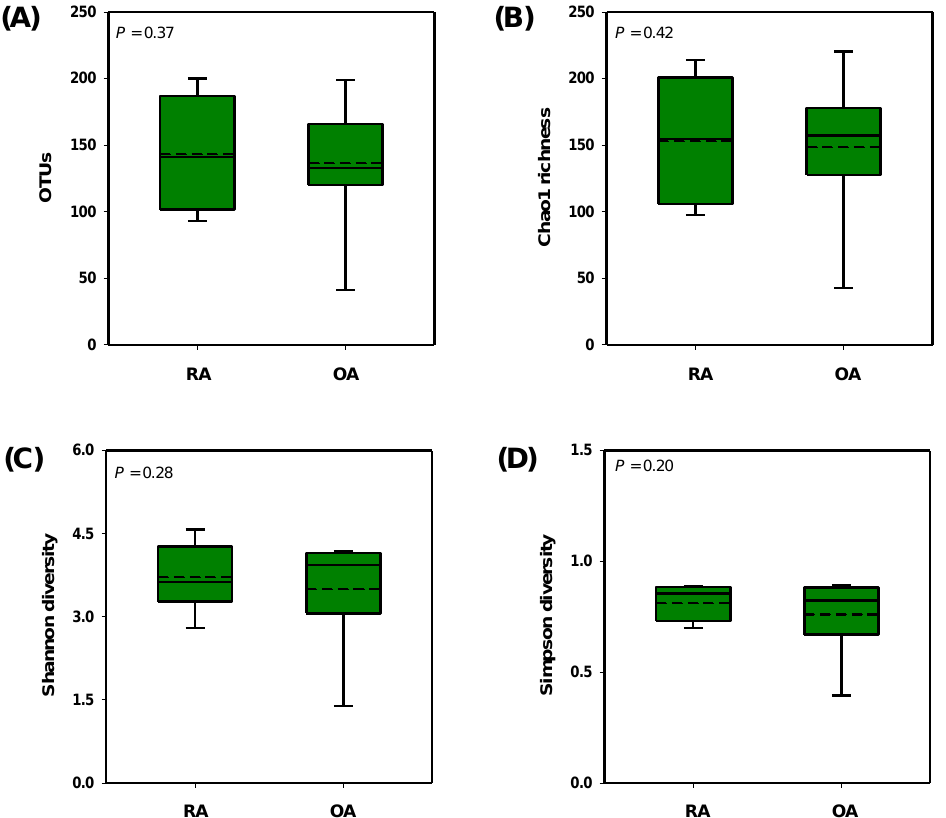
Figure 2. Box plot representing ( A ) the OTUs, ( B ) Chao1 richness, and ( C ) Shannon Diversity and ( D ) Simpson diversity Indices from the fecal sample of rheumatoid arthritis (RA) and osteoarthritis (OA) patients. Means and medians ( n = 9 for each group) are shown with straight and dashed lines, respectively, inside the box; p -values shown on top left side of each graph were based on independent samples t -test. Figure 2